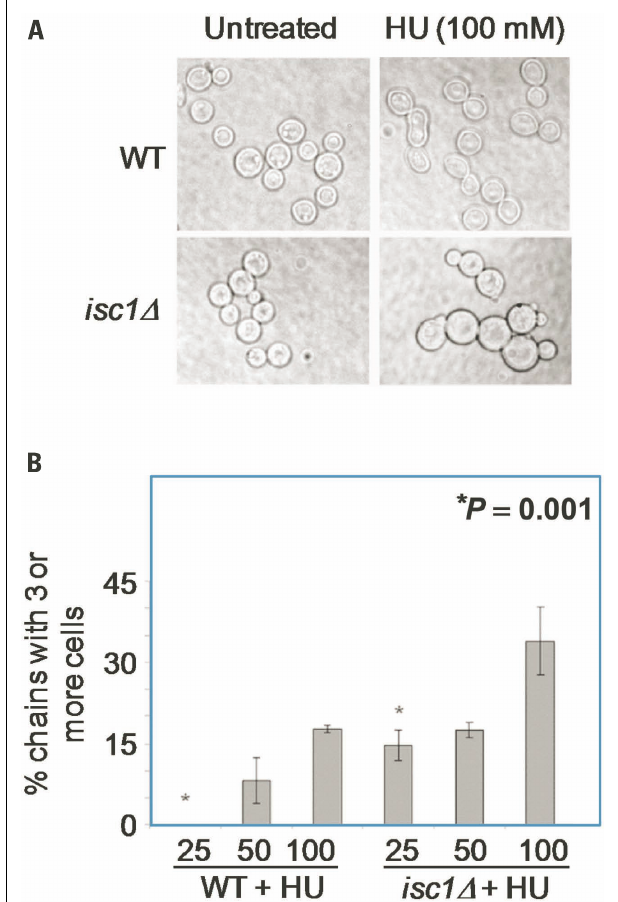
FIGURE 2 | Cryptococcus neoformans cells show HU-induced defects in morphology and cell division. (A) Cn WT and isc1 (cid:2) cells were treated with HU overnight and observed under phase contrast microscope ( × 1000). Cn isc1 (cid:2) cells formed cell chains and clumps upon HU exposure. (B) Bar diagrams showing morphological aberrations in untreated and HU-treated Cn WT and Cn isc1 (cid:2) cells.